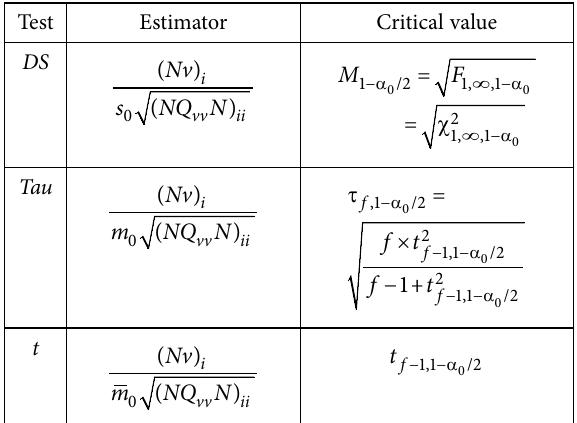
Table 1. Statistical tests and the relevant critical values (Koch 1999) Test Estimator Critical value DS